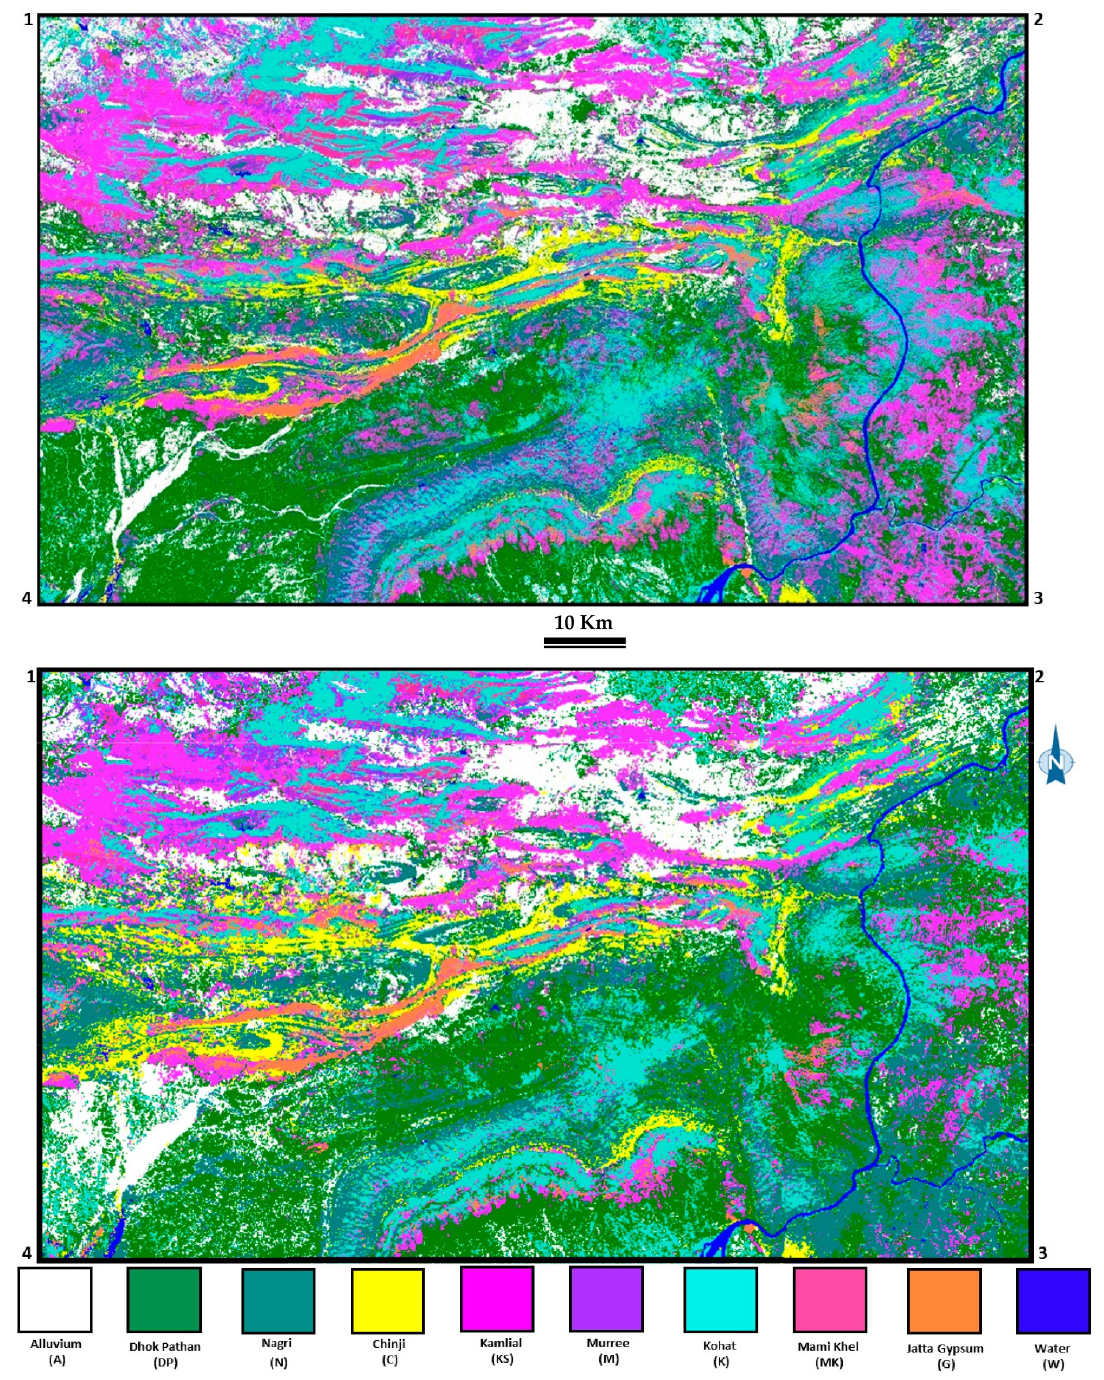
Figure 7. Final classified map using ANN (top) and SVM (bottom) bounded by the point corners (1) 33 30 ′ 9.83 ″ N, 70 45 ′ 2.05 ″ E; (2) 33 30 ′ 9.83 ″ N, 71 54 ′ 14.87 ″ E; (3) 32 55 ′ 37.63 ″ N, 71 54 ′ 14.87 ″ E; and (4)